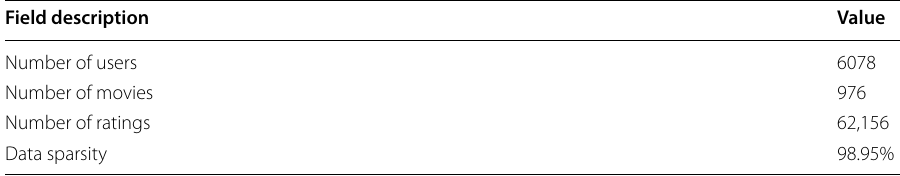
Table 3 Movies dataset